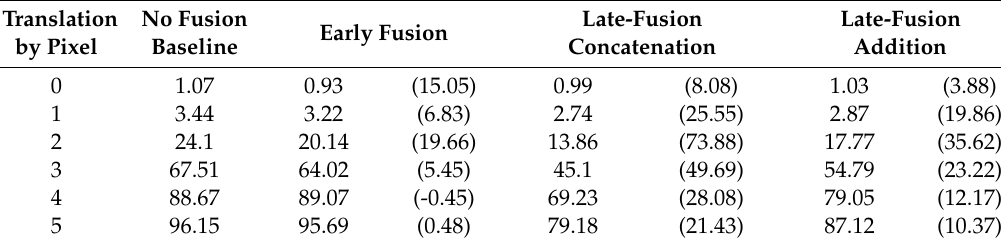
Table 3. Test error rate for a shallow network with a large kernel size (Net-1 with 15 × 15